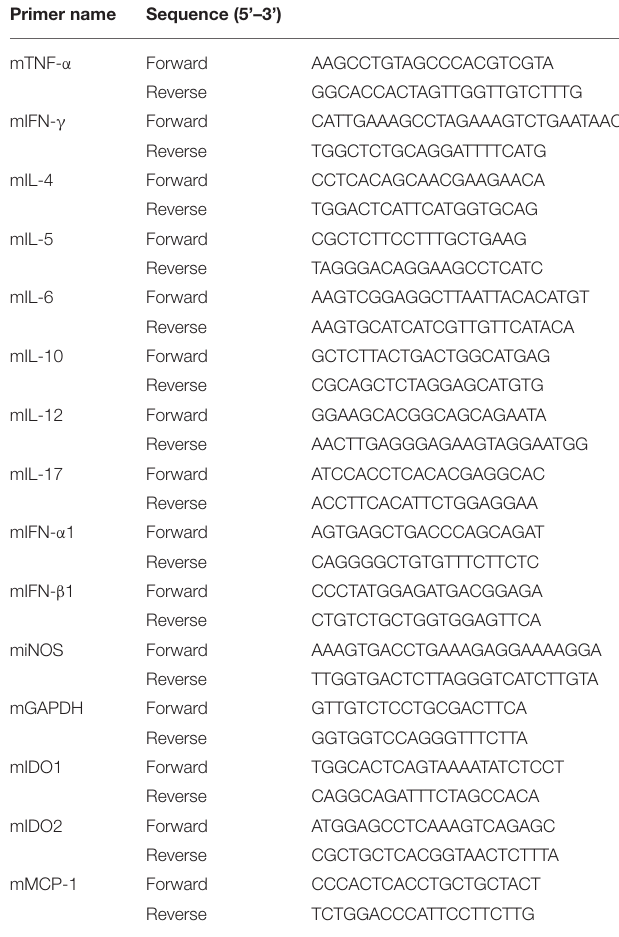
TABLE 1 | Sequences of primers used for quantitative